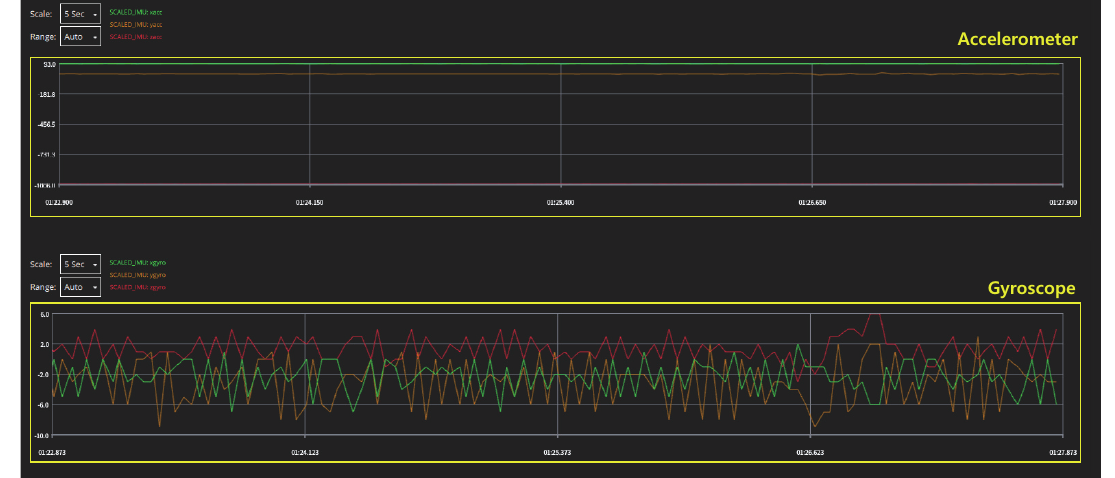
Figure 2. Real time sensor data monitoring using ’QGroundControl’ software.